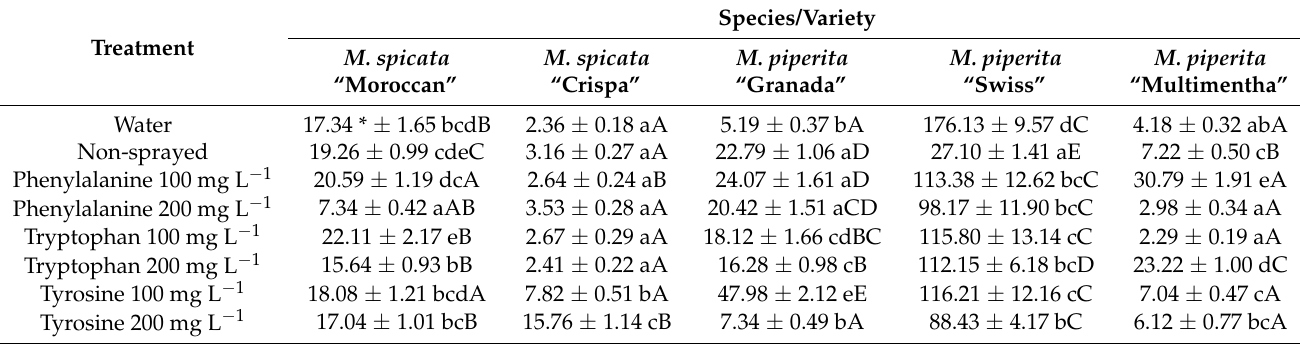
Table 6. Ferulic acid content in mints influenced by foliar application of amino acids, mg 100 g − 1 DM in 2017–2018.